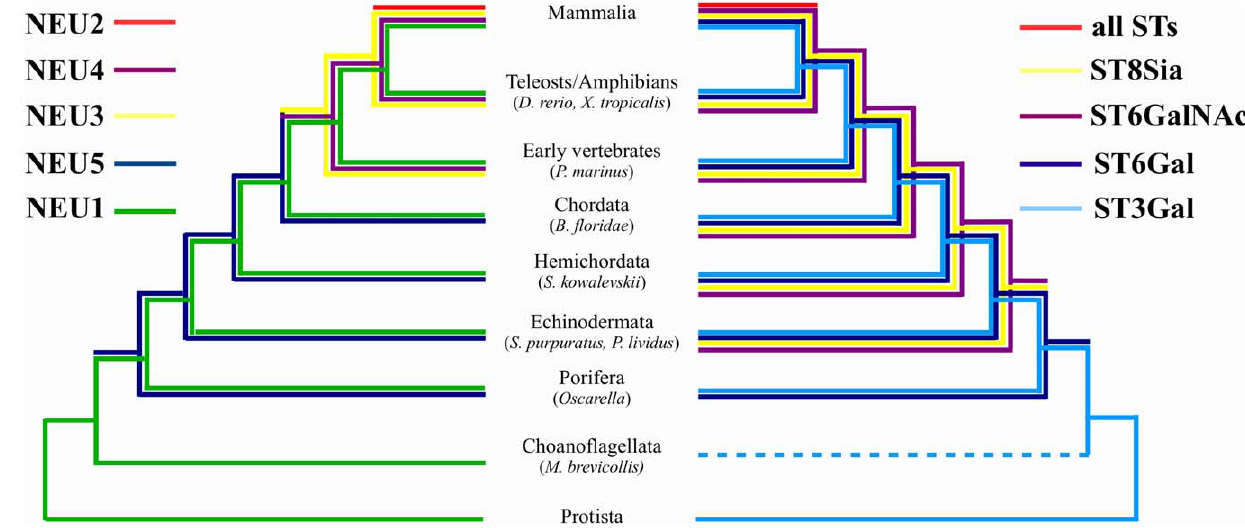
Figure 10. Co-evolution of the sialidase (NEU) and sialyltransferase (ST) gene families reconstructed using Mesquite software. Each subgroups in the two families is represented by a line of different color, NEUs on the left side, STs on the right side. The development of new classes of glycoconjugates in Echinodermata corresponds to the evolution of the NEU5 enzyme in sialidases. The appearance of the complete set of STs in Mammalia corresponds to the appearance of NEU2 in sialidase family. ST line pointing to Choanoflagellata is dotted since we were unable to retrieve any STs related sequence in Choanoflagellata and thus the actual presence of STs in this taxon can not be confirmed. Sialyltransferases are named according to